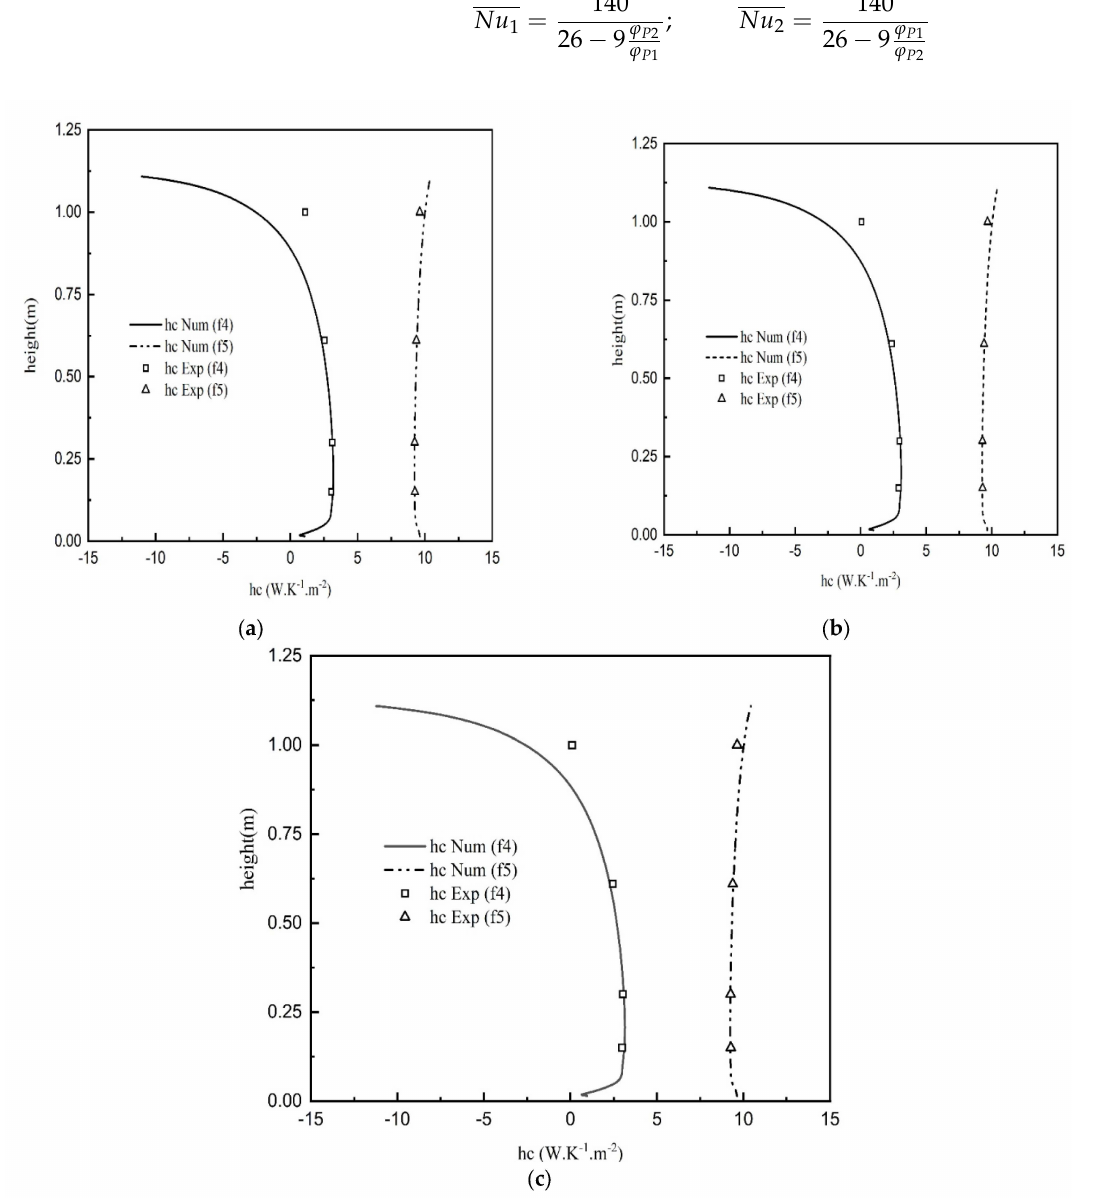
Figure 22. Numerical and experimental convective heat transfer coefficient (as measured by thermal fluxes and using Shah and London’s correlations [39], for P values of: ( a ) 190 W.m − 2 , ( b ) 320 W.m − 2 , and ( c ) 475 W.m − 2